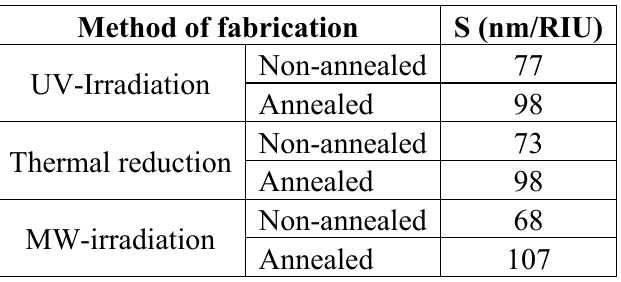
Table 1. Sensitivity of Au-PMMA nanocomposite samples prepared by different